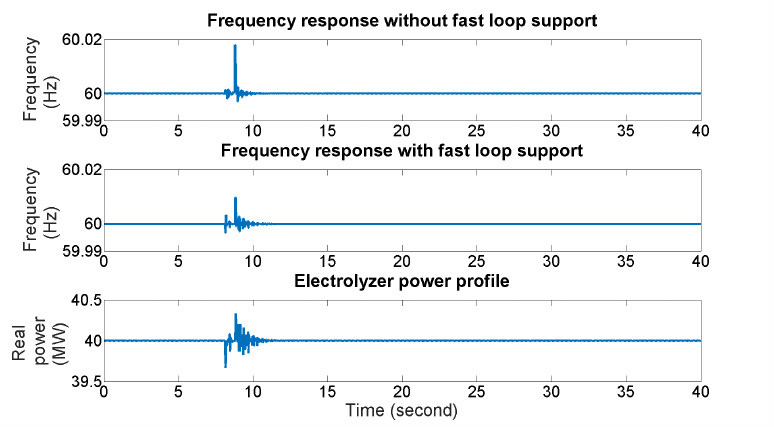
Figure 10. Case study: frequency support from large-scale hydrogen refueling